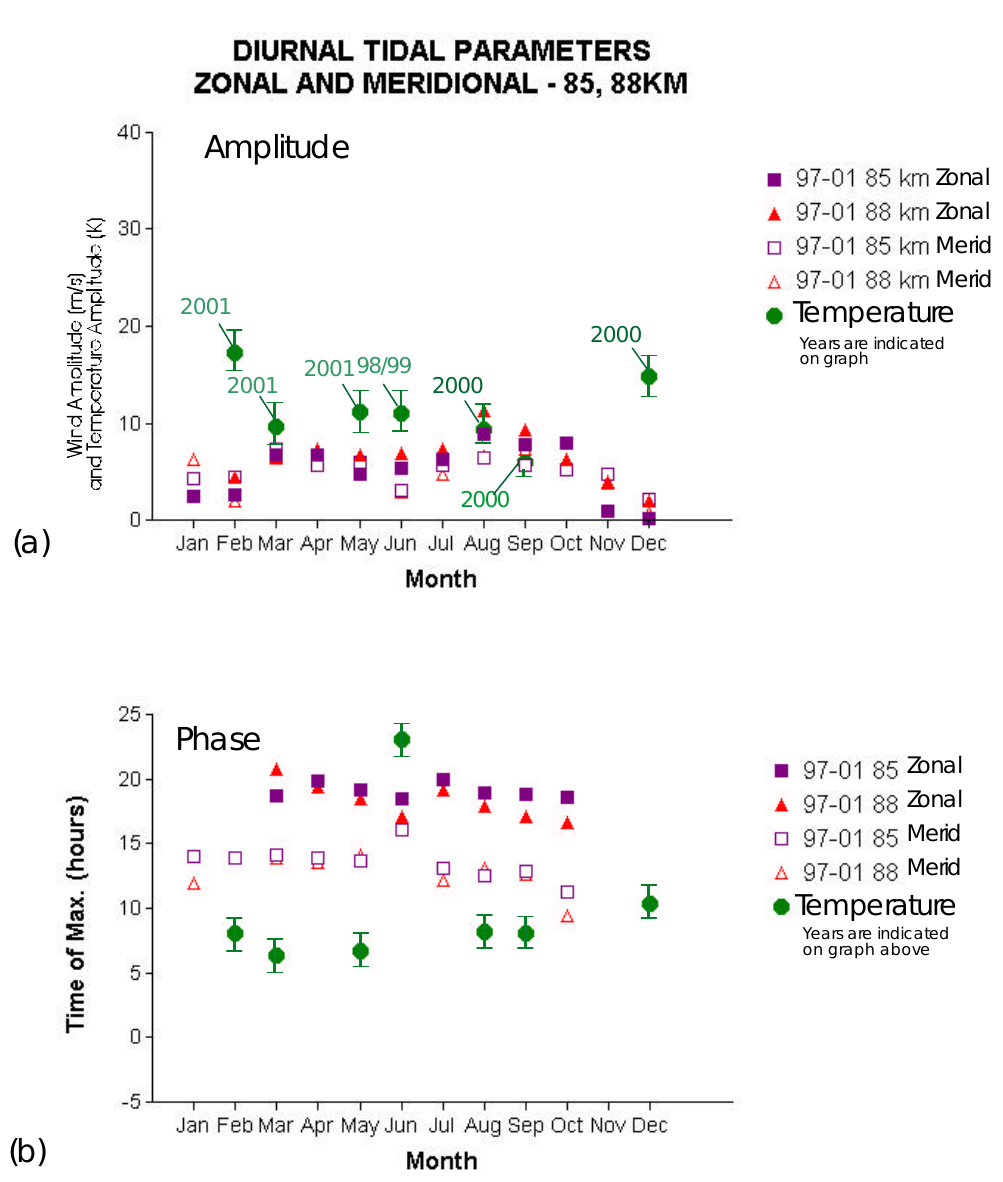
Fig. 11. Tidal parameters deduced by the meteor radar at Resolute Bay, Canada (75 ◦ N). These graphs include both wind and temperature diurnal temperature parameters. The wind data represent vector averages for each month, with useful data over the period 1997 to 2001. Due to poorer data rates, and in some cases the existence of terdiurnal tides, it has not always been possible to deduce the temperature tides, so only data for selected months in selected years are shown. The wind data are shown for both 85 and 88 km altitude, while the temperature data are shown for the height of peak meteor detection (typically 85 km in winter and 88 km in summer for this 51.5 MHz